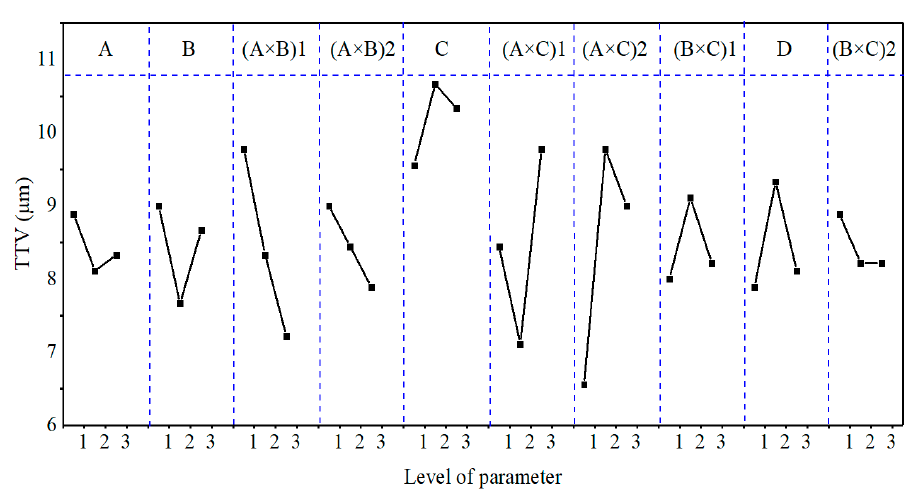
Figure 7. The effect plot for TTV.